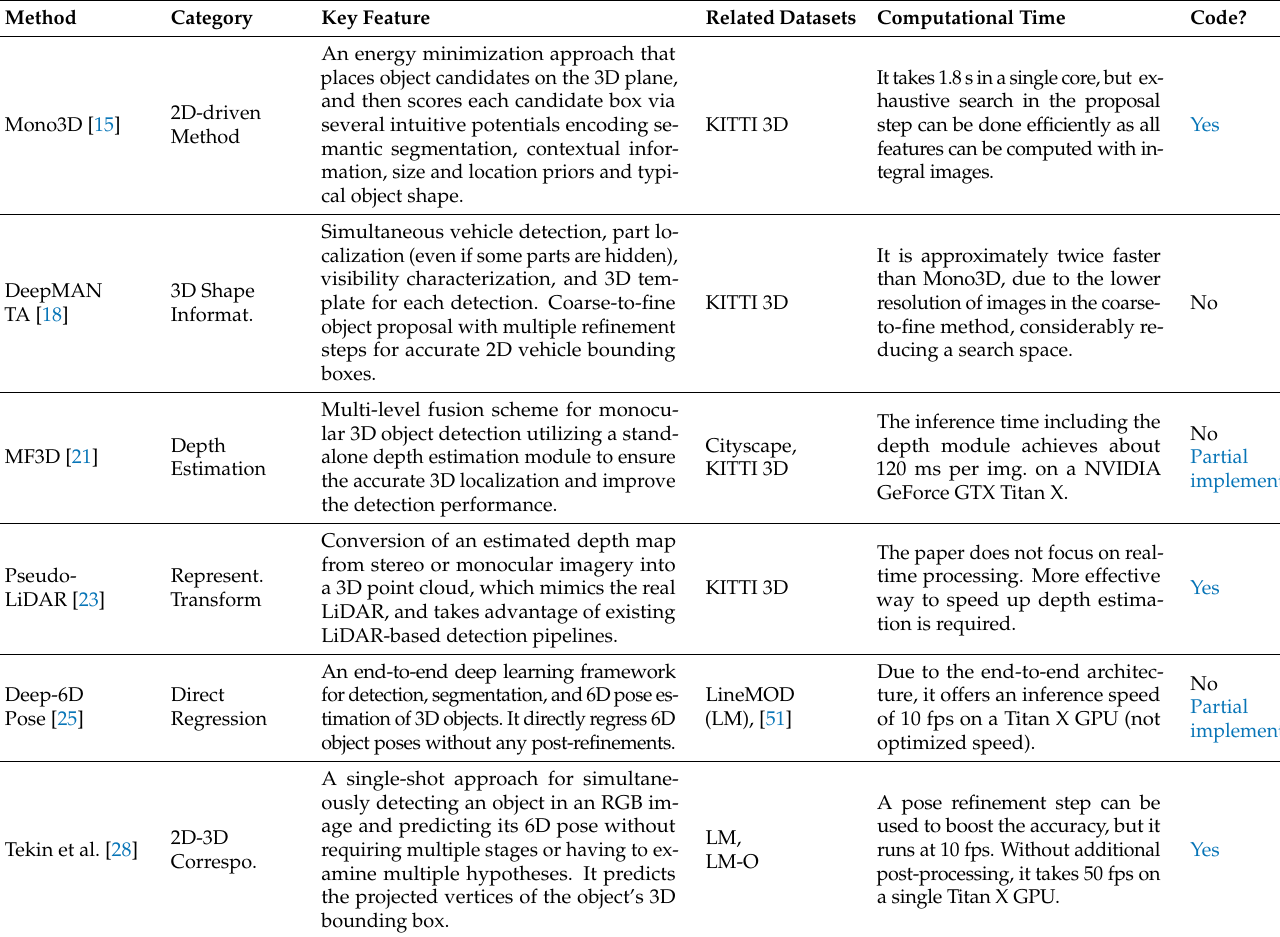
Table 2. Representative monocular 3D object detection